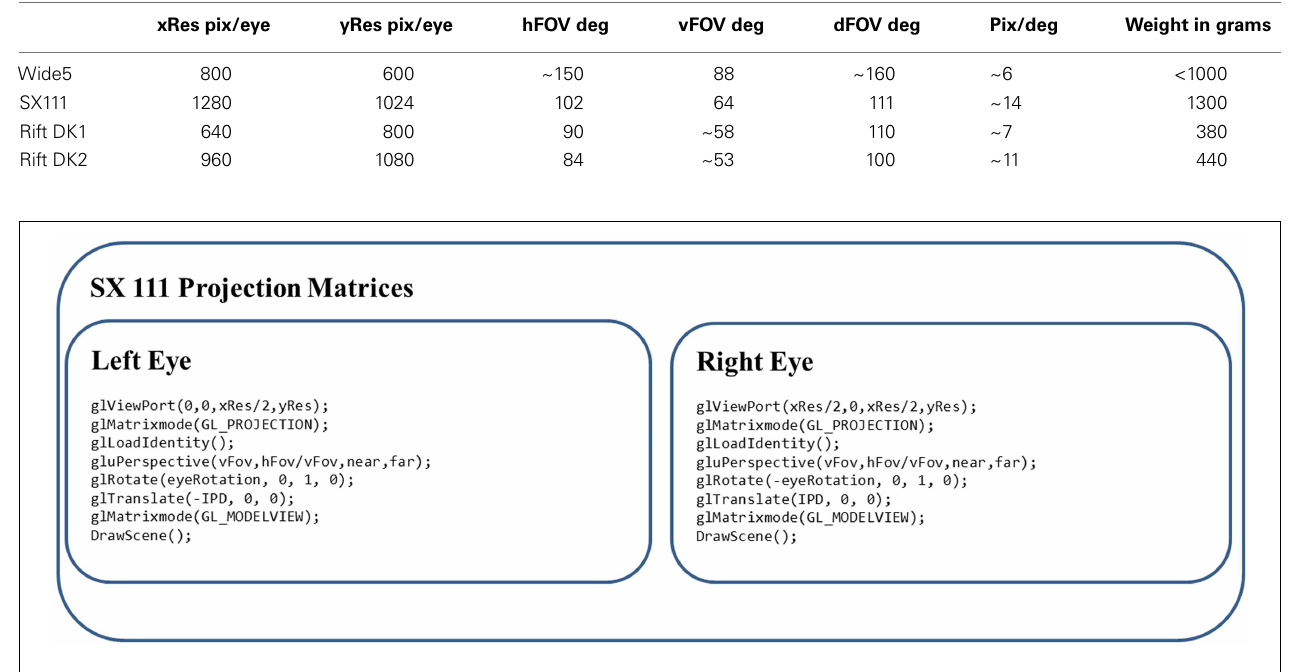
FIGURE 3 | SX111 HMD OpenGL commands required to setup the matrices for the left and right eye display . According to manufacturer specifications xRes = 2560; yRes = 1024; hFov = 76; vFov = 64; eyeRotation = 13.0; IPD 0.064; and we set the near and far clipping plane to 0.01 and 1000,